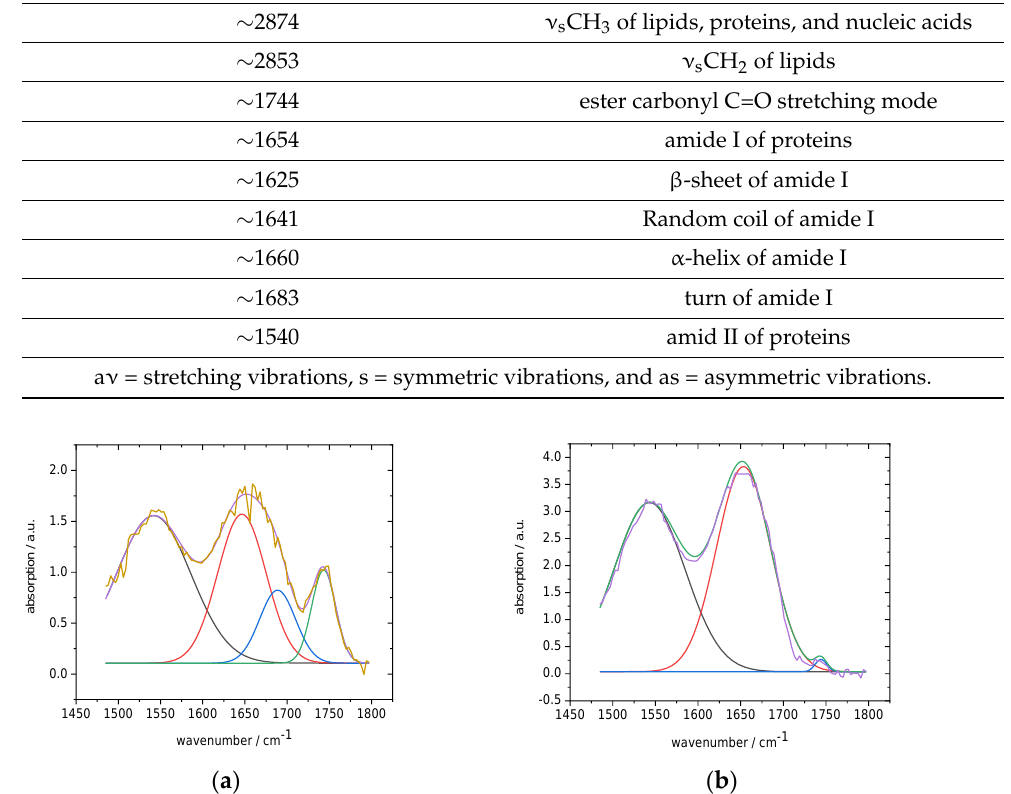
Table 1. Assignment of some relevant vibrational bands and components [36–39]. Table 2. Initial fitting parameters. Four Gaussians for the control group and three Gaussians for the BPC-treated group, with maximal number of iterations = 200 and tolerance = 10 − 6 .